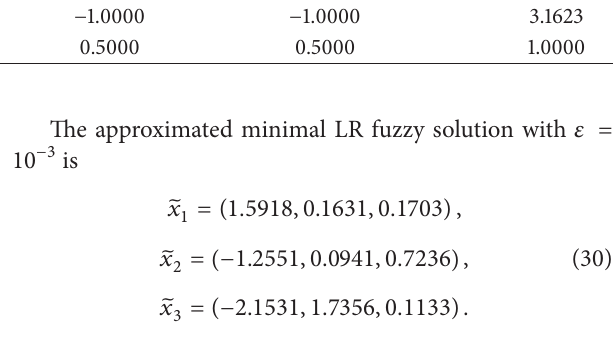
Table 3: Finding the mean